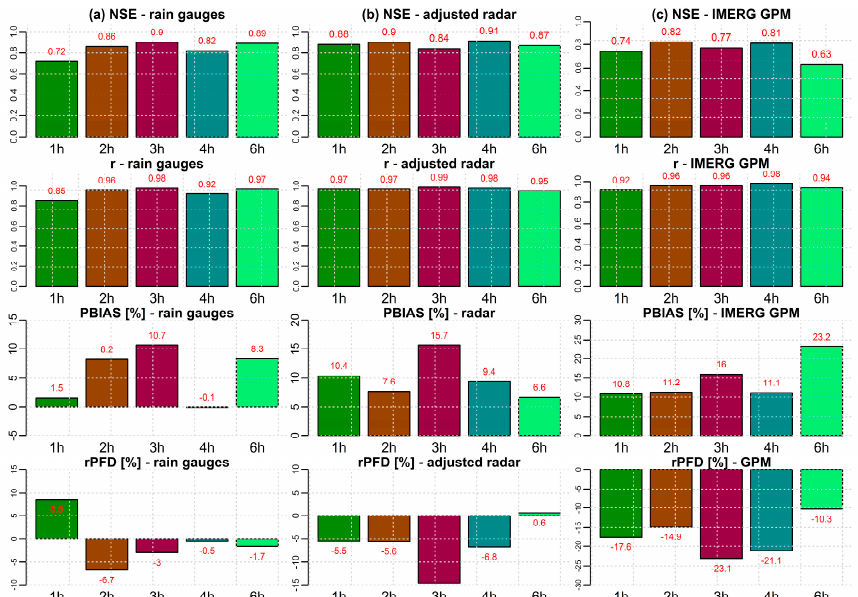
Figure 9. Comparison of the evaluation metrics performance (in columns) for Event 4 for aggregated time-steps simulations based on ( a ) rain gauge precipitation, ( b ) adjusted radar rainfall estimates, ( c ) IMERG GPM satellite rainfall estimates.